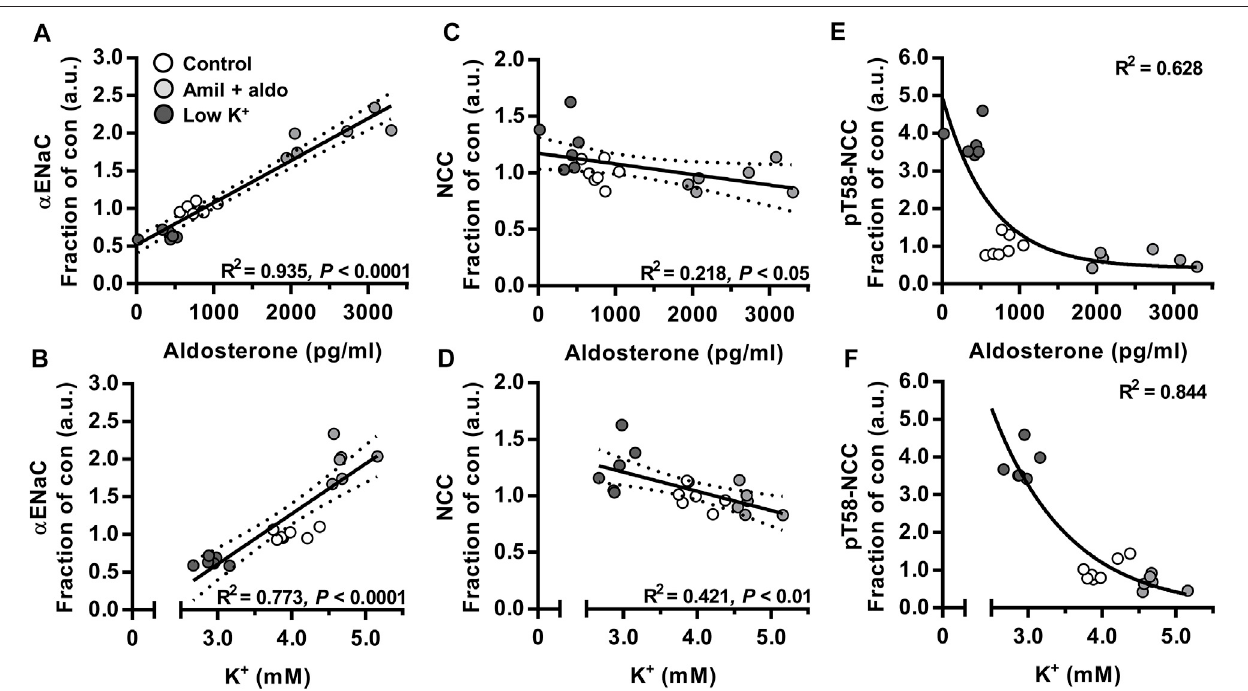
FIGURE 2 | Plasma aldosterone and K + correlated positively with cleaved α ENaC but negatively with NCC and pT58-NCC. Data on mice that were infused with amiloride + aldosterone (amil + aldo) or fed a low K + for 6 days ( Figure 1 ) were further analyzed using regression modeling. n = 7 per group (Control) or n = 6 per group (amil + aldo and low K + diet). Data were analyzed using linear (A – D) or non-linear regression analysis [one-phase decay model (E,F)